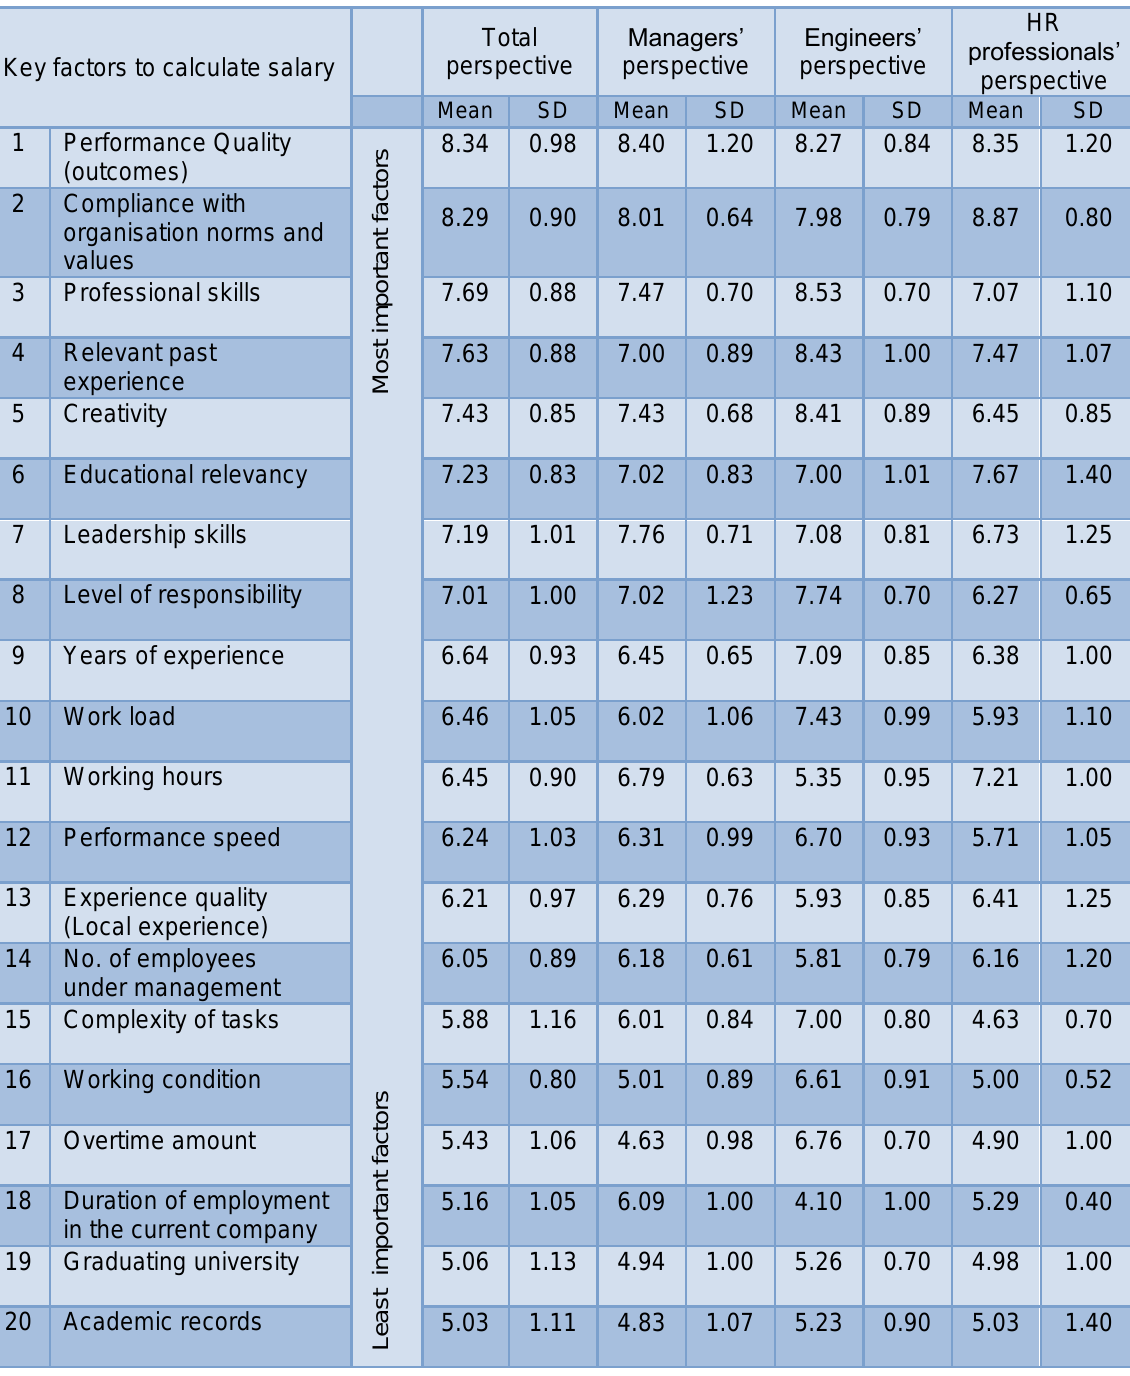
Table 3 Influencing factors on salary calculation: Diverse perspectives across construction